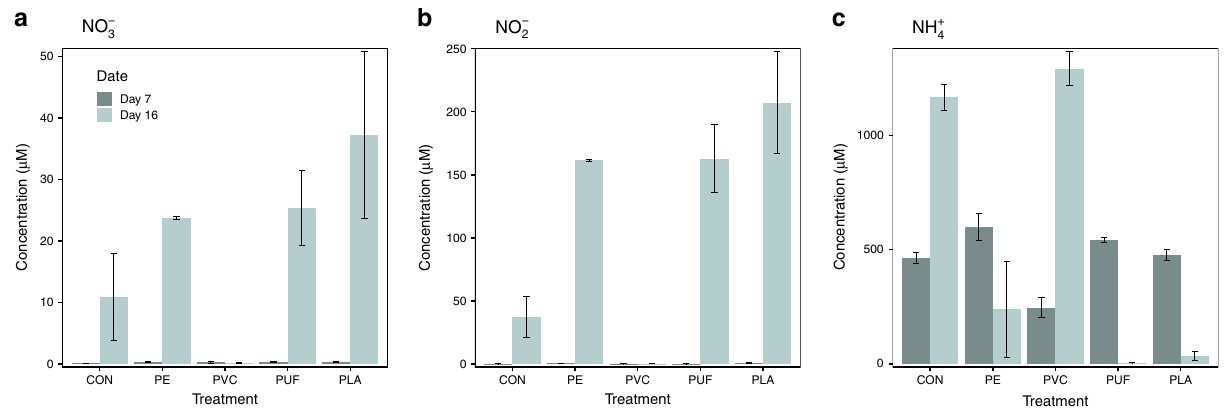
Fig. 4 Dissolved inorganic nitrogen concentrations in water. Concentrations ( µ M) of NO 3 − a , NO 2 − b , and NH 4 + c are shown for each microplastic treatment and control microcosms after 7 and 16 days of incubation ( n = 3 per treatment). Error bars are standard error and CON is the control treatment. Initial community ( n = 1) concentrations are 0.072, 0.527, and 3.44 µ M for NO 3 − , NO 2 − , and NH 4 + , respectively. Statistical analyses can be found in Supplementary Tables 2 – 4.